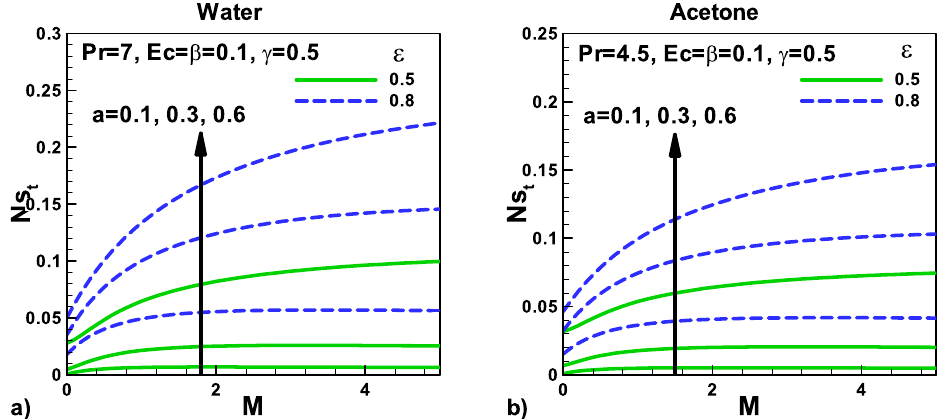
Figure 8. Variation of total entropy generation rate with magnetic field and velocity ratio parameter at different positions for ( a ) water ( b ) Acetone.